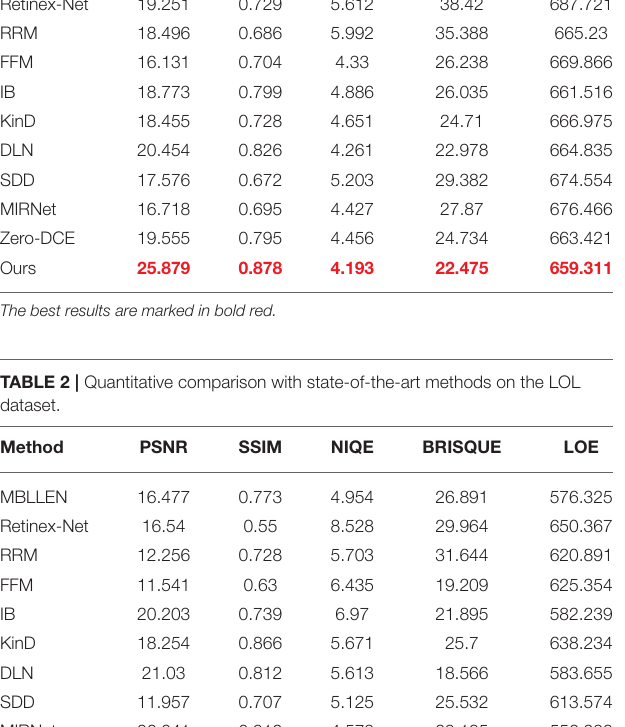
The best results are indicated in bold